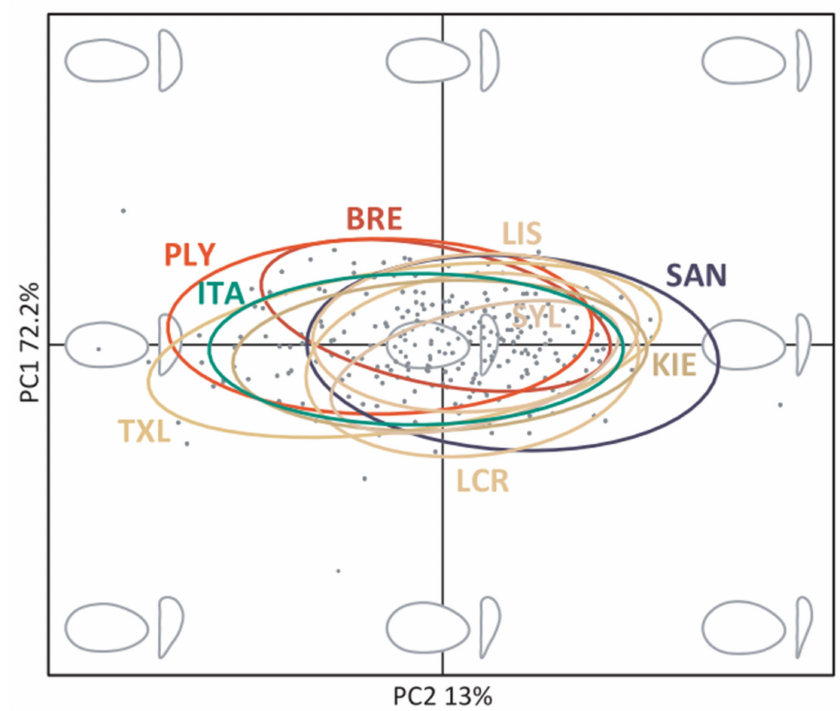
Figure 4. Scatterplot of individual variation in the first two principal components (PCs) from a PCA performed on elliptic Fourier analysis coe ffi cients of lateral and anterior left shell views. The amounts of variation explained by each PC are given as percentages and the ellipses represent 95% confidence intervals for each population. The ellipses are color coded according to the main genetic groups discovered by Structure (shown in Figure 3d). Extreme and average reconstructed shell outlines are shown in